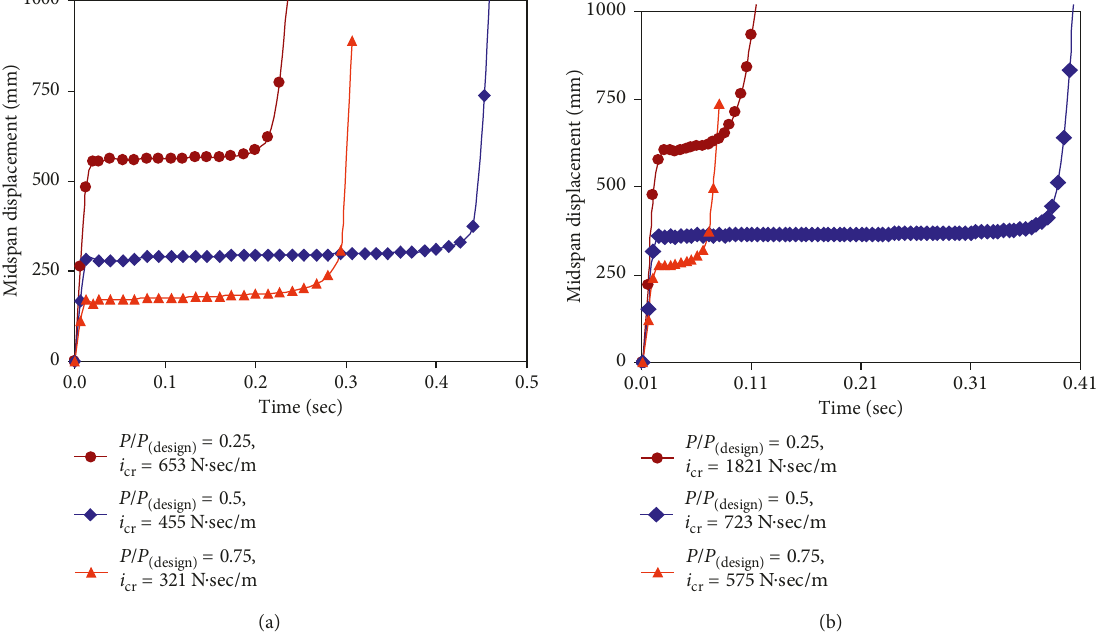
Figure 13: Midspan displacement time histories of steel column W200 (b) Propped